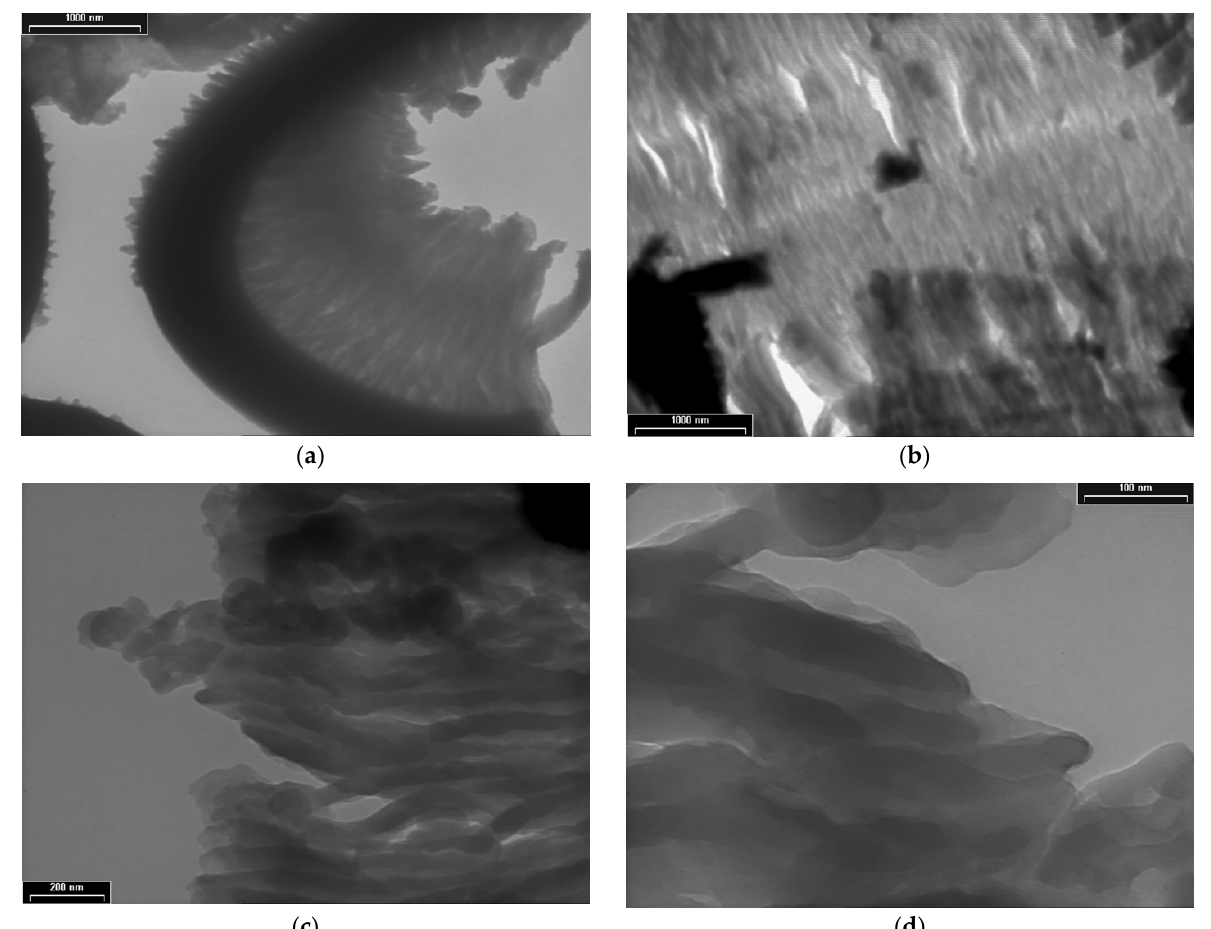
Figure 5. TEM images of PDPA thin films at various magnifications, with scale bars ( a ) and ( b ) 1000 nm; ( c ) 200 nm; ( d ) 100 nm. ( b ) 1000 nm; ( c ) 200 nm; ( d ) 100